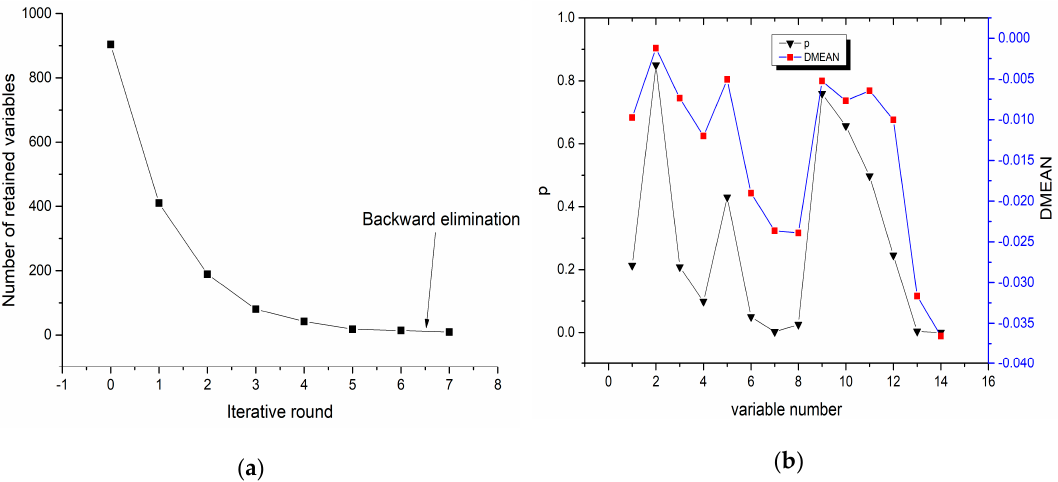
Figure 5. Iteratively retaining informative variables (IRIV) iterative process and wavelength type decision parameter values obtained using the field spectral reflectance. ( a ) Number of retained variables in the iterative rounds of IRIV; ( b ) DMEAN and p value in the 6th iteration.